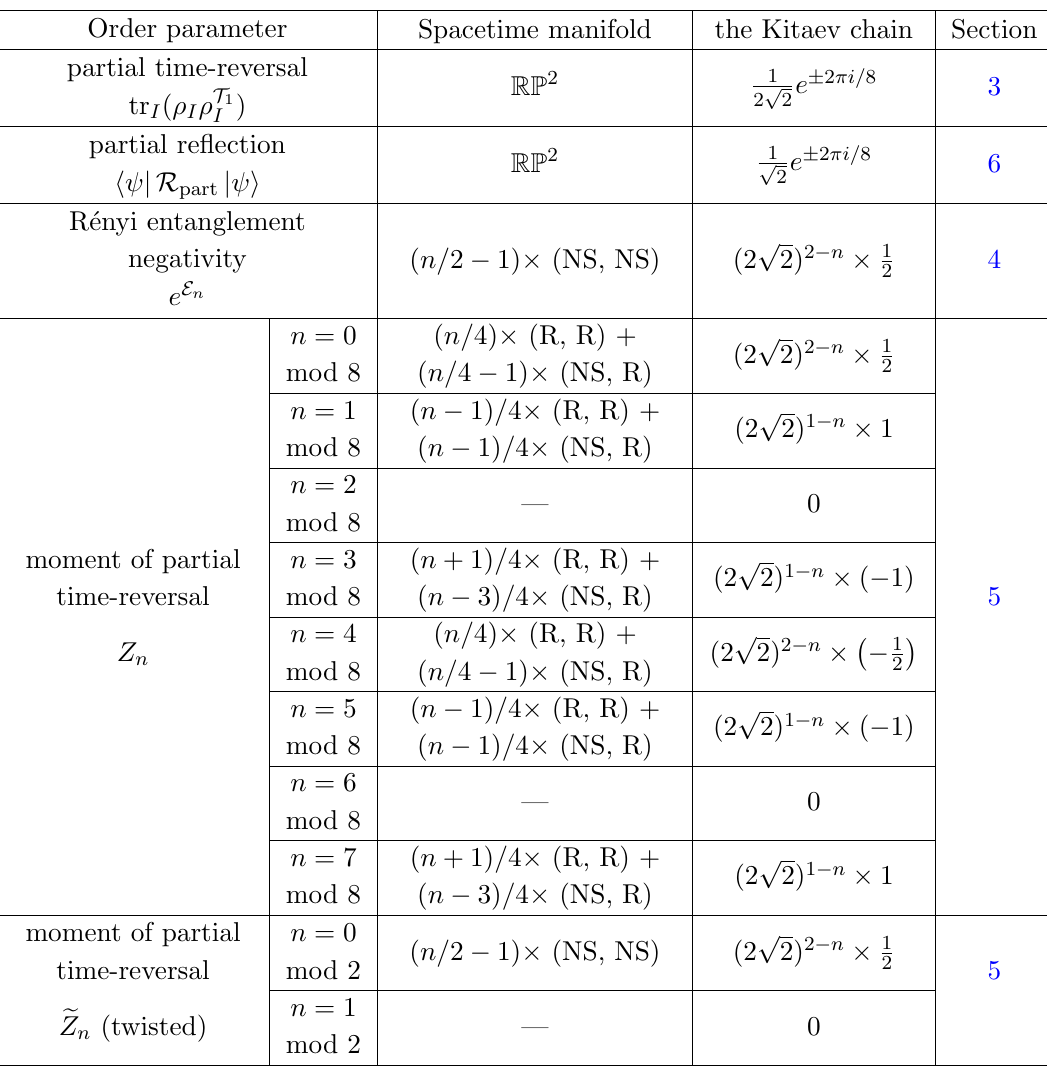
Table 1 . List of many-body order parameters for fermion SPT phases formulated in lattice TQFT. lattice TQFT generating the Z classi(cid:12)cation, the bordism invariant corresponds to the 8 Arf-Brown-Kervaire